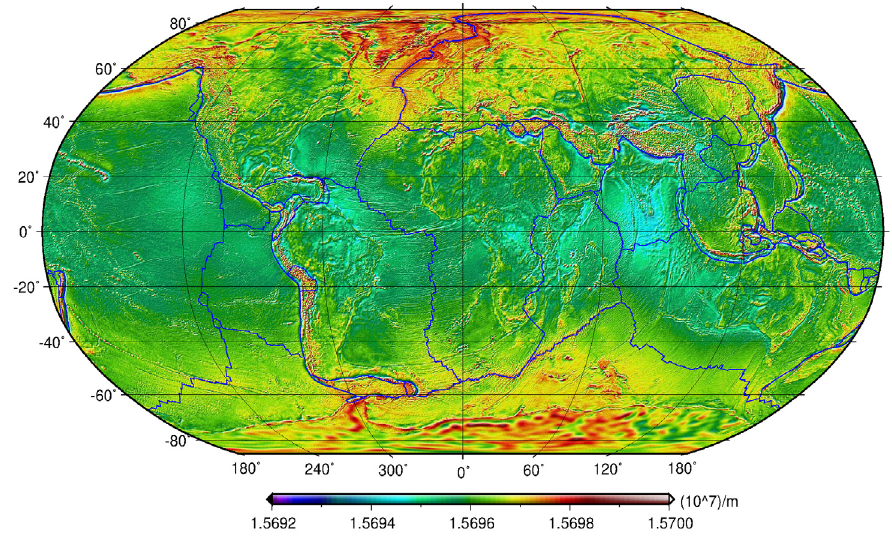
Figure 3. Mean curvature [10 -7 /m] of the EGM2008 level surface V = const ( ––– basic plates